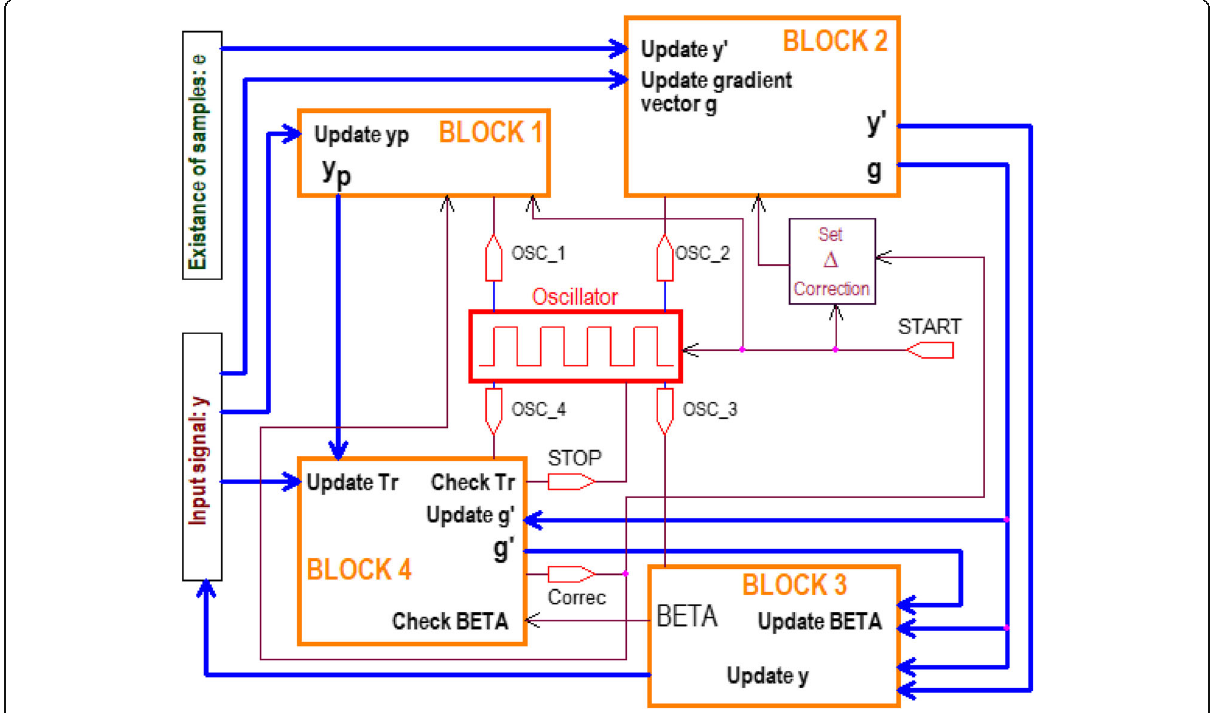
Fig. 1 The block scheme of the proposed analog architecture